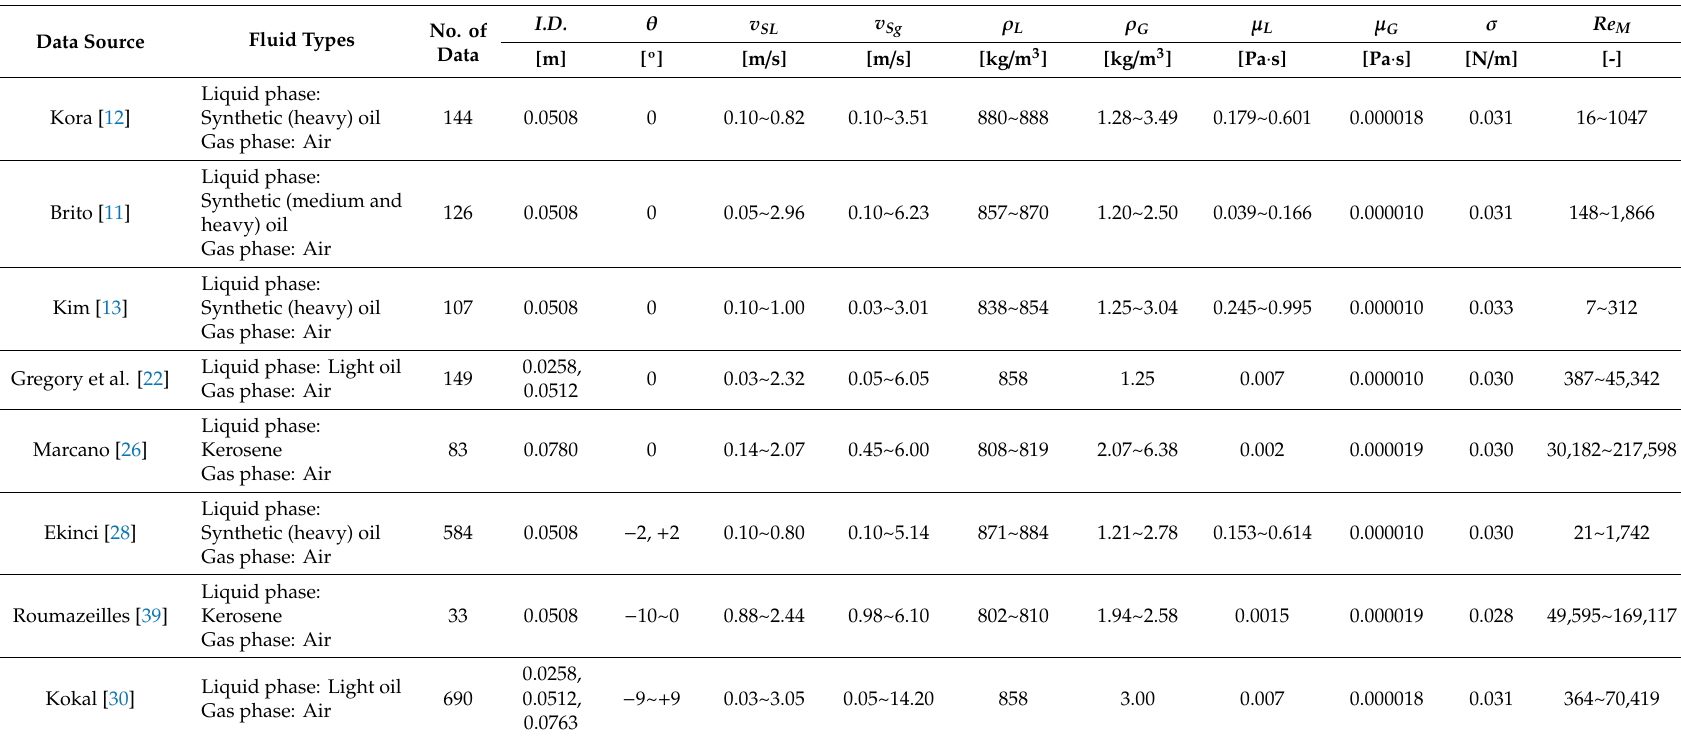
Table 3. Summary of slug liquid holdup, H LLS ,